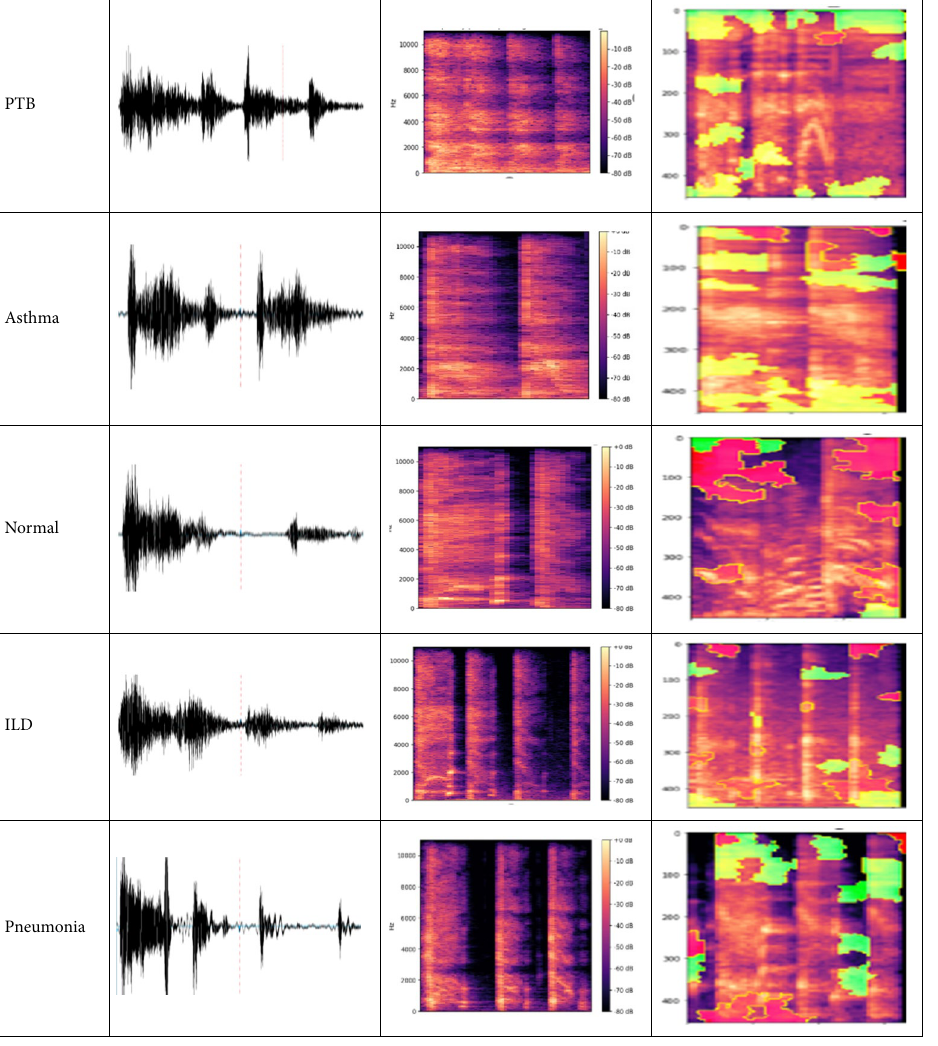
Table 2. List of different respiratory diseases showing characteristic cough signature, cough spectrograms and related LIME